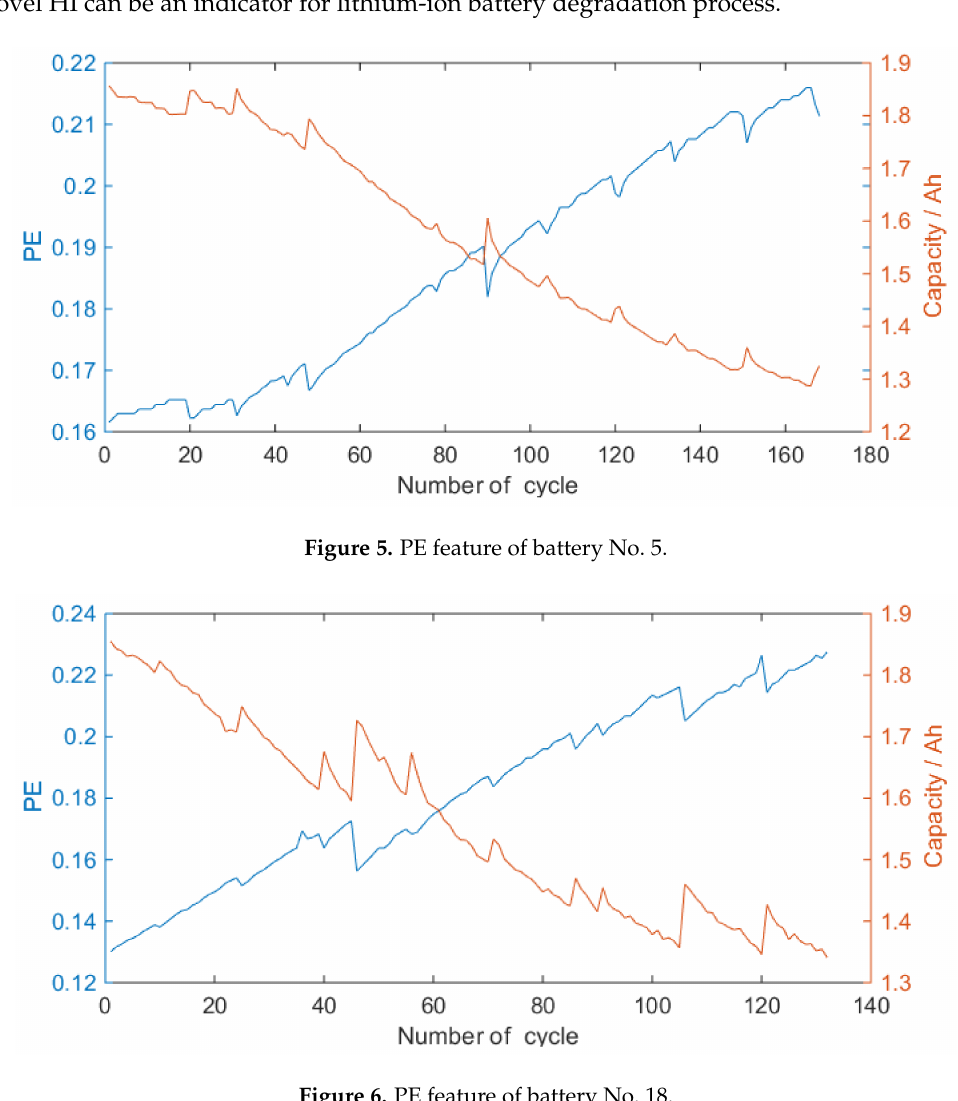
Figure 6. PE feature of battery No. 18.